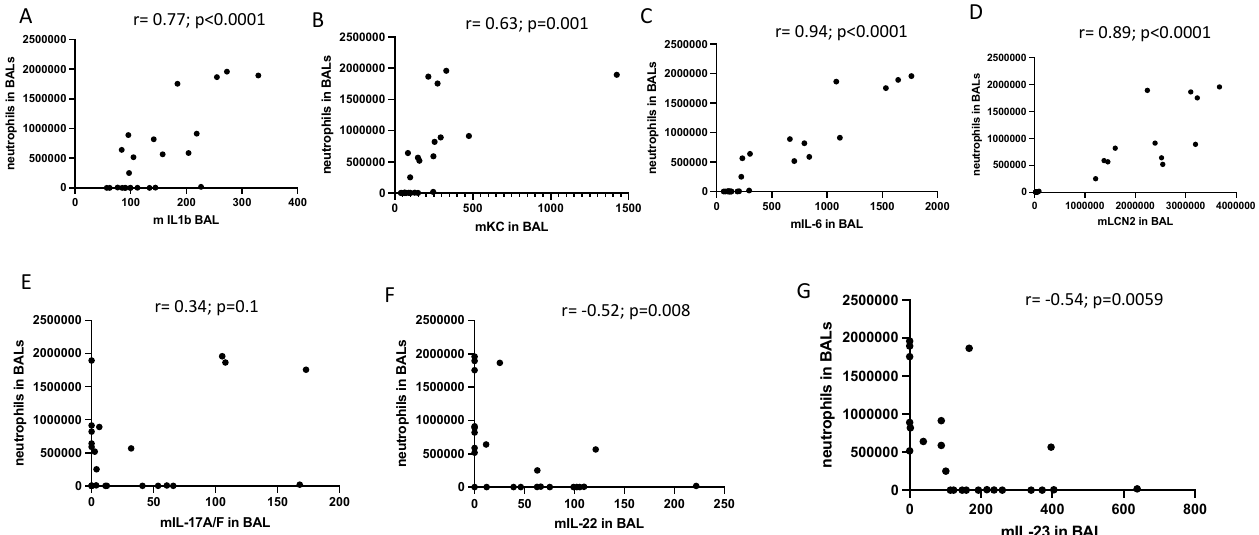
Figure 4. The BAL protein levels of IL-1b, KC, IL-6 and Lcn-2 correlate positively with BAL neutrophil influx, but not those of IL-23 and IL-22.